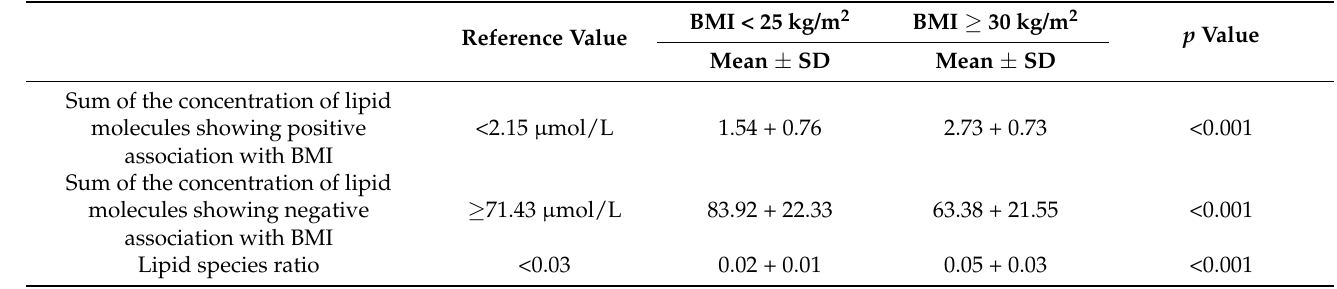
Table 4. The estimated reference values and the mean of the sum of concentrations of lipid species showing positive and negative association with body mass index and lipid species